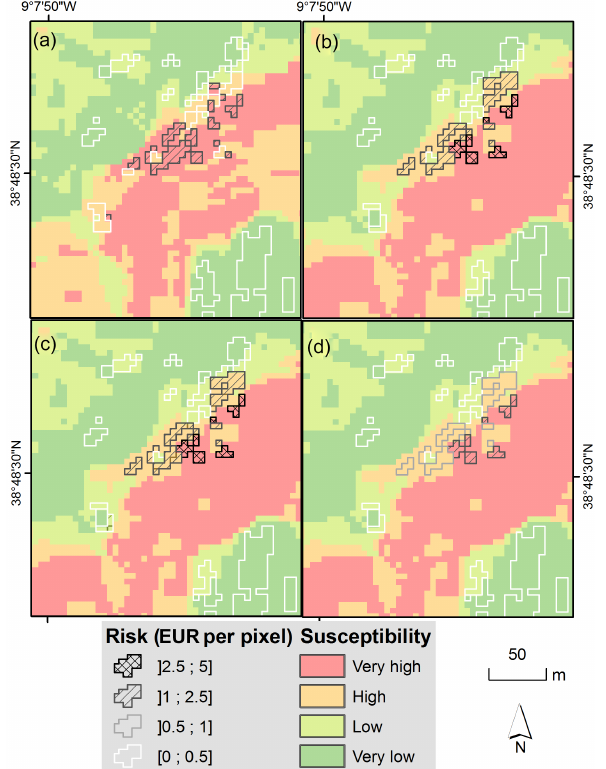
Figure 14. Detail of annual risk for buildings of the Loures mu- nicipality located on a landslide foot, for affected material that is (a) 0.5m, (b) 1m, (c) 3m, and (d) 5m high. Pixel size: 5m. For location, see Fig. 6.